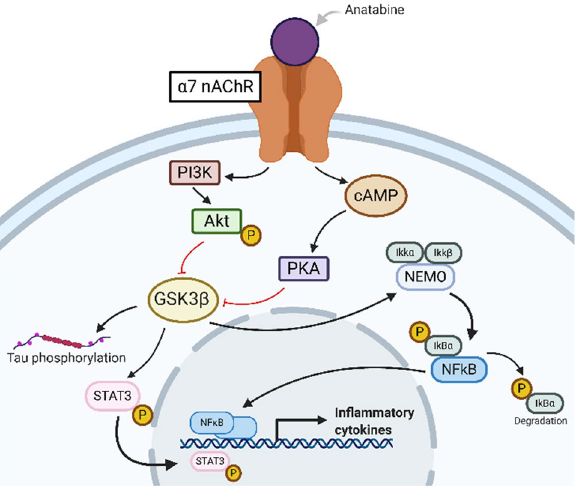
Figure 1. Anatabine acts as an agonist of α7 nAChR which activates PI3K-Akt and cAMP-PKA signaling pathways. Both Akt and PKA phosphorylate GSK3β at Ser9 which results in its inhibition. Inactivation of GSK3β leads to a decrease of phosphorylation of tau and of STAT3, preventing the latter from translocating into the nucleus and initiating transcription of inflammatory cytokines. Similarly, phosphorylated GSK3β fails to phosphorylate the Ikk/NEMO complex which is responsible for activation of